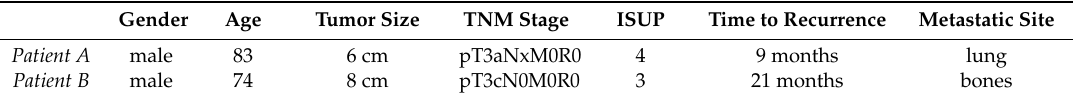
Table 2. Clinical characteristics of the two patients that present high levels of EV-derived TIMP-1 mRNA in the pre- and post-surgery